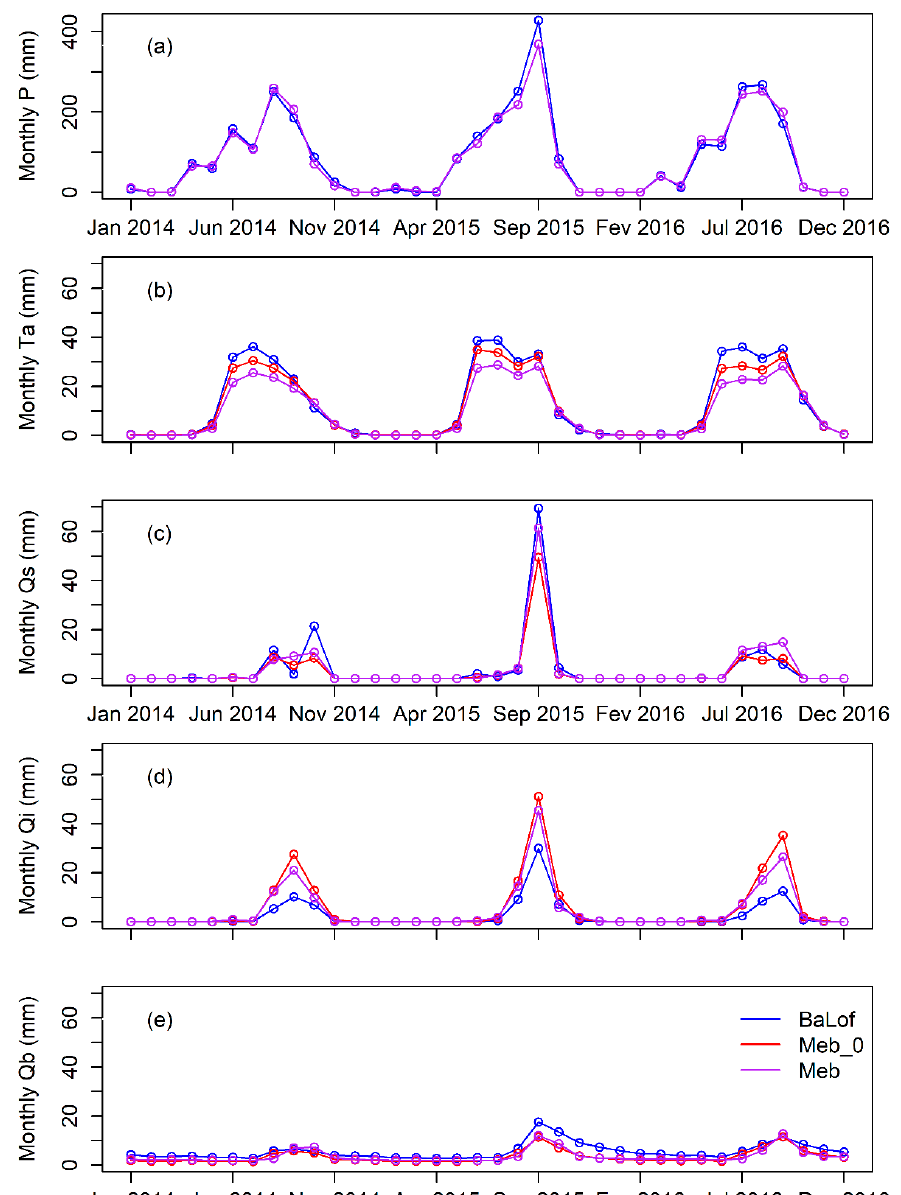
Figure 14. Monthly variation of ( a ) precipitation (P), ( b ) actual transpiration (Ta), ( c ) surface runoff (Qs), ( d ) interflow (Qi), and ( e ) base flow (Qb) in Bankandi ‐ Loffing (BaLof), Mebar before recalibration (Meb_0), and Mebar after recalibration (Meb) from 2014 to